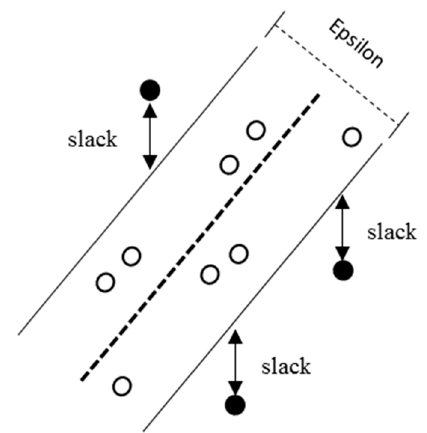
Figure 4. Procedure of support vector regression from an input sample.